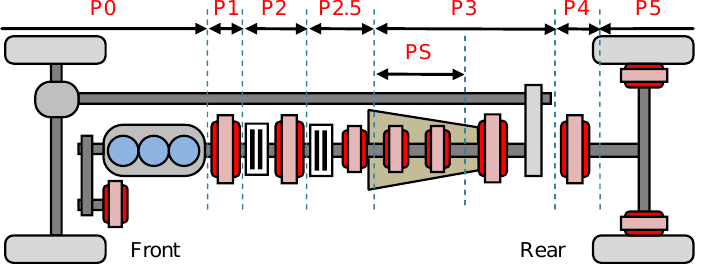
Figure 1. Topology of hybrid drive systems (based on [23]); P0 — electric motor is used only to start the combustion engine or to use it as a starter – alternator; the power is transmitted by a V-belt; P1 — electric motor in inserted between the combustion engine (ICE) and the clutch; configuration P2 — contains the electric motor placed behind the clutch; intermediate configuration P2.5 — designates the positioning of the electric motor in a dual clutch transmission (DCT) [24]; P3 configuration — indicates the electric motor is mounted at the output of the transmission; combin- ing two electric motors with a planetary gear results in a power split (PS) [25]; mounting the electric motor on the rear axle is the P4 solution; P5 architecture — electric motors are placed in the wheels of the vehicle; a combination of solutions is possible (also in terms of 4 × 4 drive systems).